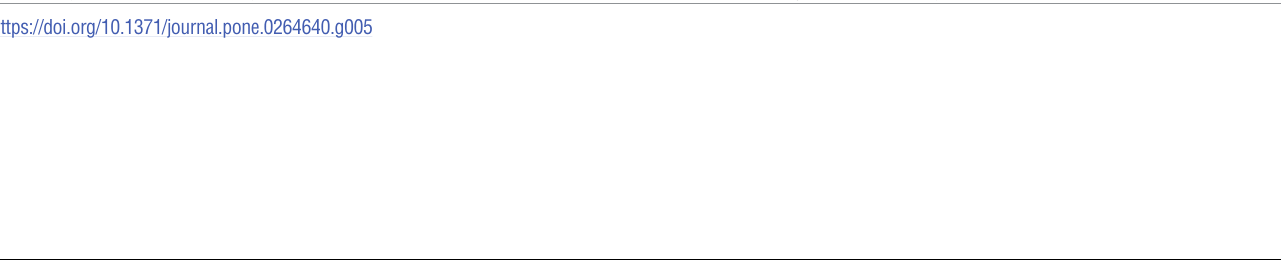
PLOS ONE | https://doi.org/10.1371/journal.pone.0264640 March 8,